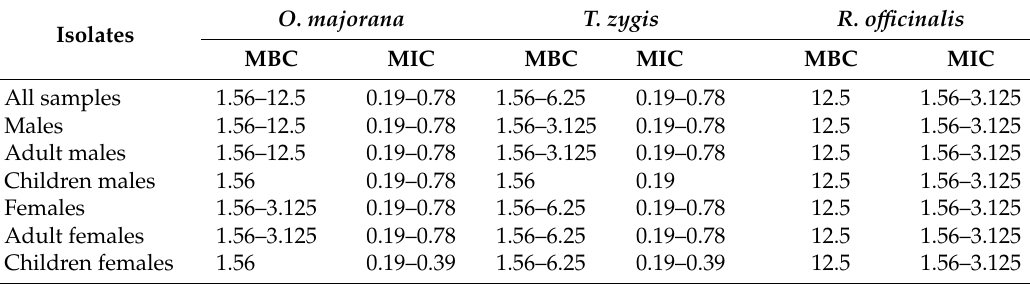
Table 3. The minimal inhibition concentration (MIC) and minimal bactericidal concentration (MBC) values (mg/mL) of essential oils (Eos) against E. coli isolates tested with micro-dilution assay. Isolates